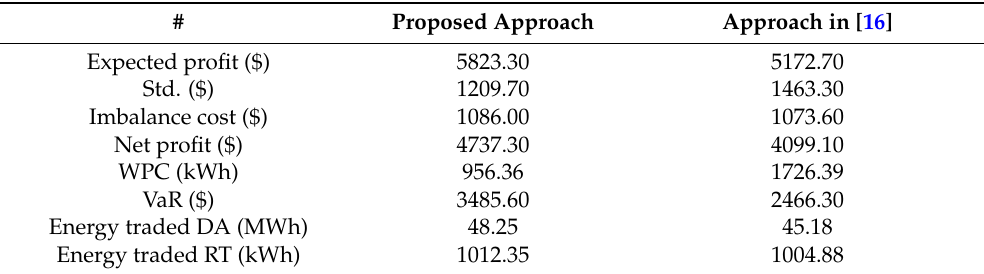
Table 6. Result comparison to an approach in the